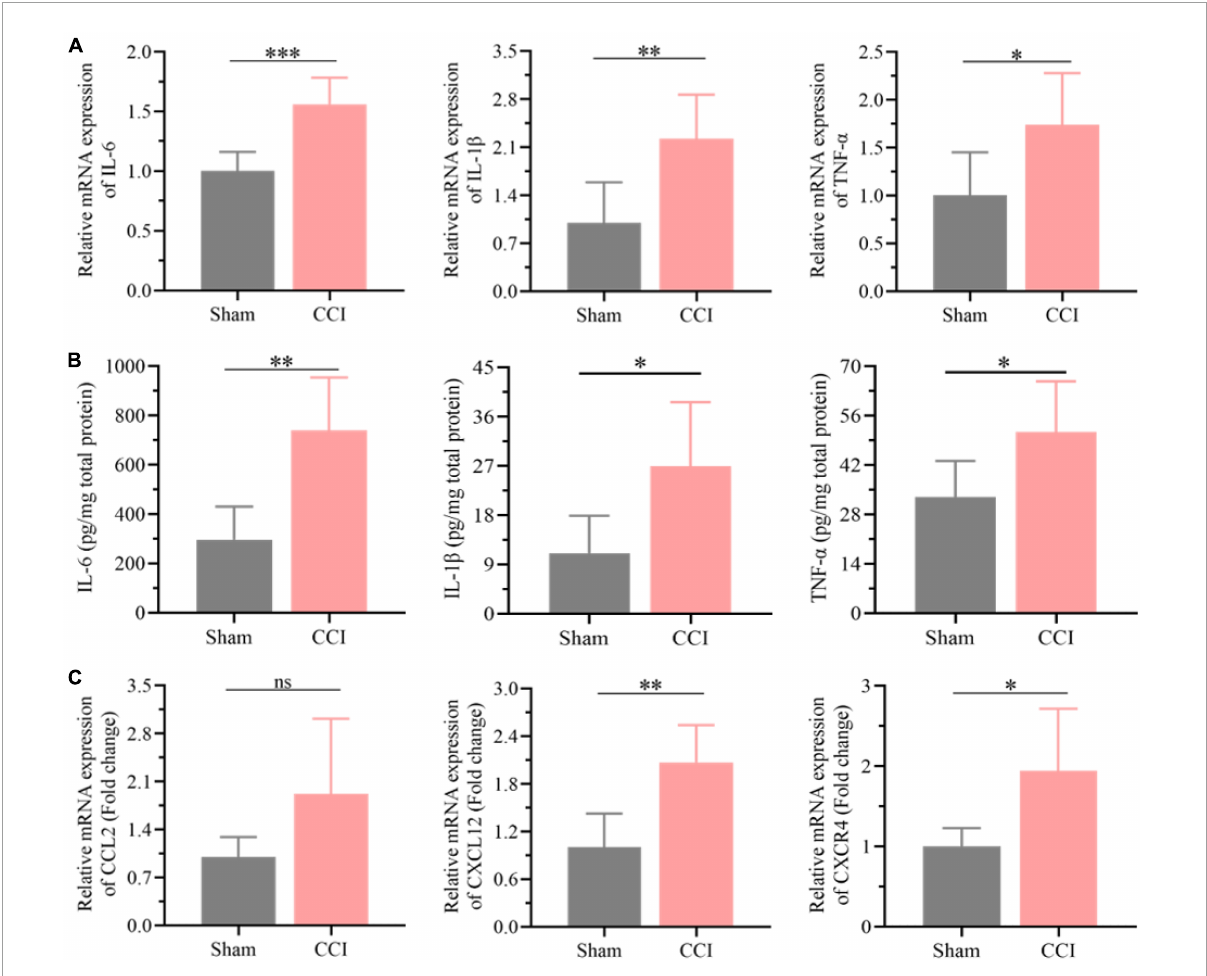
FIGURE5 Neuroinflammation was substantially elevated in the hippocampus post CCI. (A) The expression levels of proinflammatory cytokines, including IL-6 , IL-1 β and TNF- α , in the hippocampus of CCI and sham rats were detected by qRT-PCR. (B) CCI induced upregulation of these proinflammatory cytokines in the hippocampus as detected by ELISA. (C) The expression levels of inflammation-related proteins, including CCL2 , CXCR4, and CXCL12, in the hippocampus of CCI and sham rats were detected by qRT-PCR. Error bars represent the mean ± SD ( n = 6), and the statistical analysis was conducted via unpaired Student’s t -test. ∗ P < 0.05, ∗∗ P < 0.01, ∗∗∗ P < 0.001, ns represent no